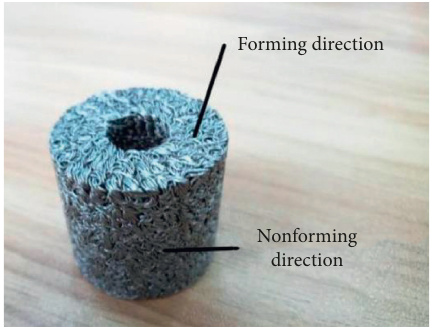
Figure 4: Different forming directions of